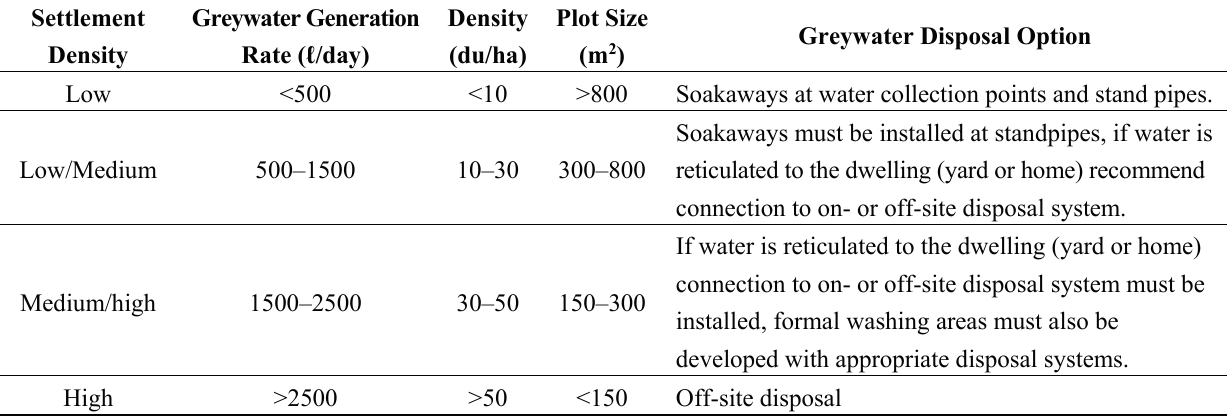
Table 2. Greywater management guidelines from Carden et al. [17]. Environmental impacts of greywater disposal practices will be influenced by important environmental factors including soil surface properties, topography, water table depth, and proximity of the area to environmentally sensitive environments (see Table